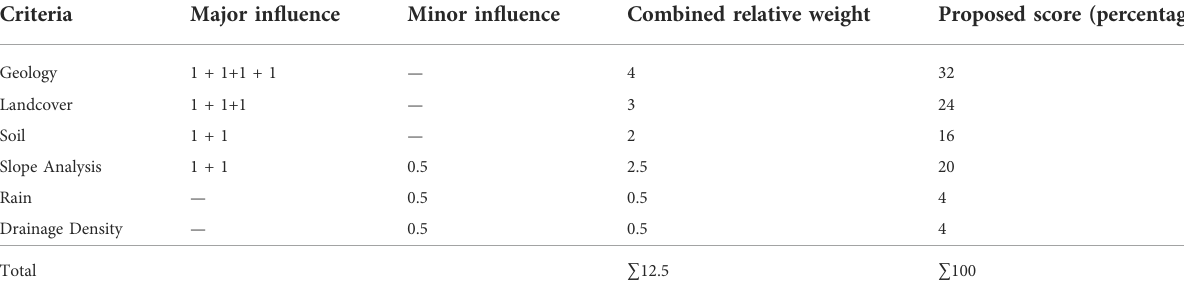
TABLE 3 Relative weight and score assignment of each criterion using the MIF method.